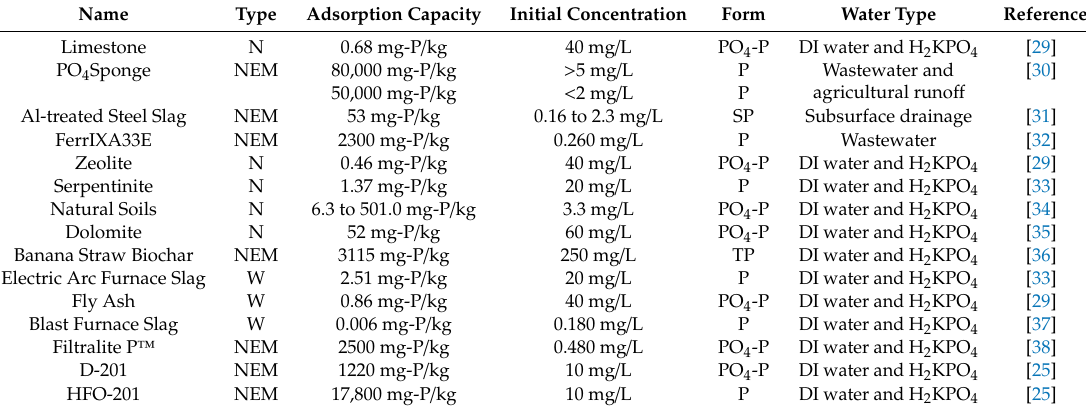
Table 1. Di ff erent types of natural, waste, and nano-engineered phosphorous (P) adsorption